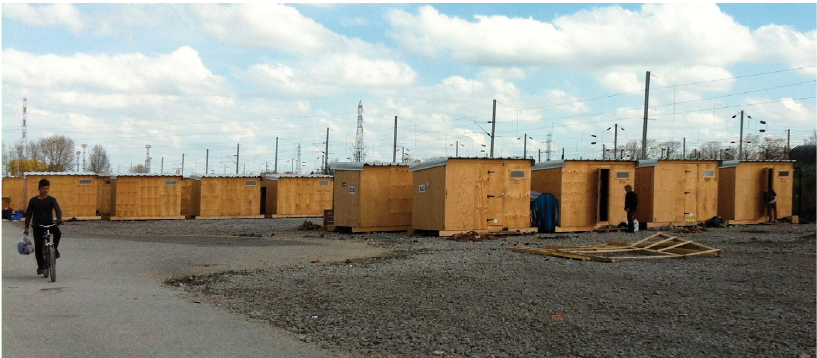
Figure 4. La Linière camp in Grande-Synthe, France, April 2016. Photo by